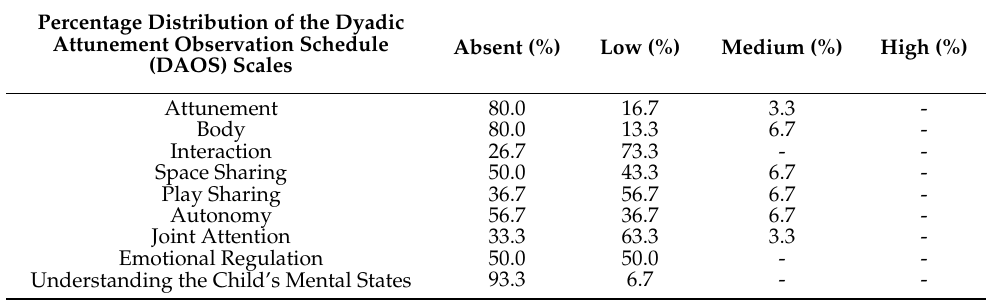
Table 3. Percentage distribution of the Dyadic Attunement Observation Schedule (DAOS) scales. Percentage Distribution of the Dyadic Attunement Observation